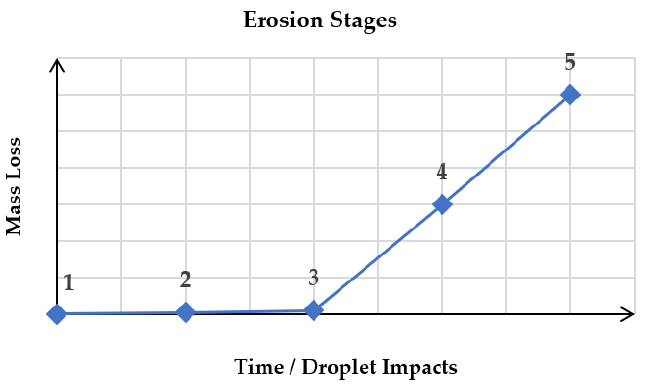
Figure 1. Erosion stages, typical mass loss plot.